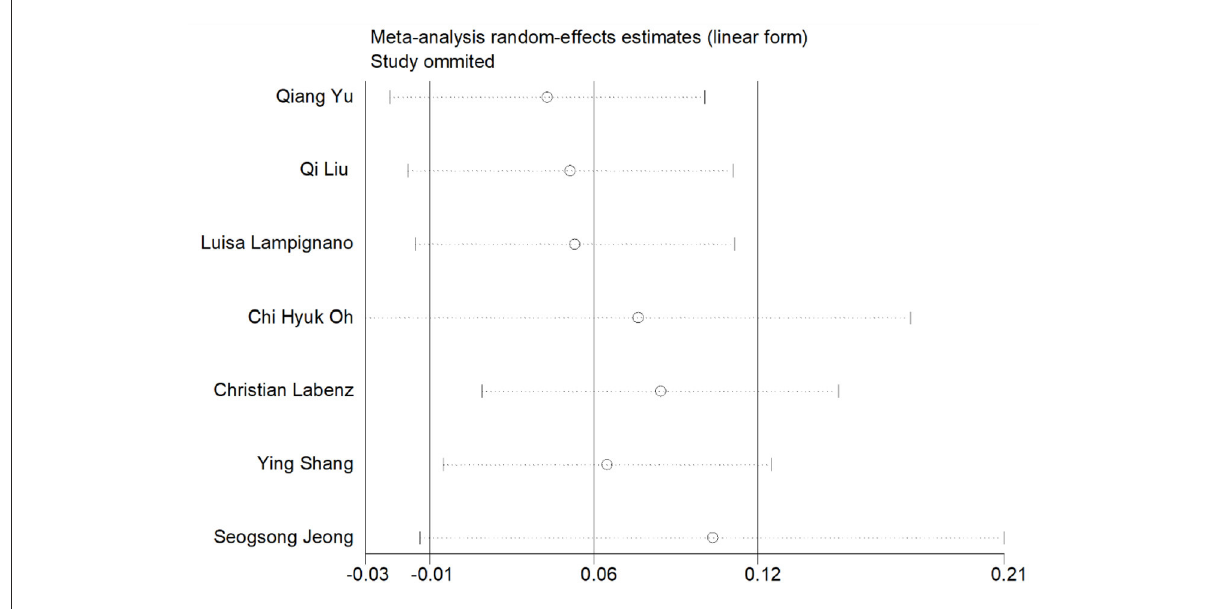
FIGURE3 Sensitivity analysis of the risk of all-cause dementia and cognitive impairment caused by NAFLD.